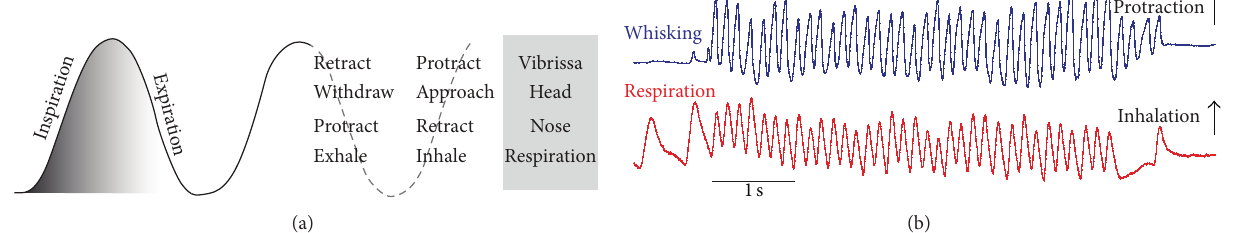
Figure 1: Cooccurrence of sniffing and whisking in rodents. (a) Sniff and whisk cycles are coordinated with nose and head movements (adapted from Welker [1]). (b) The motion of vibrissa D2 was monitored by high-speed videography (250 frames per second), and sniffing was recorded by means of a thermocouple implanted in the nasal cavity. In all figures inspiration and vibrissa protraction are up.